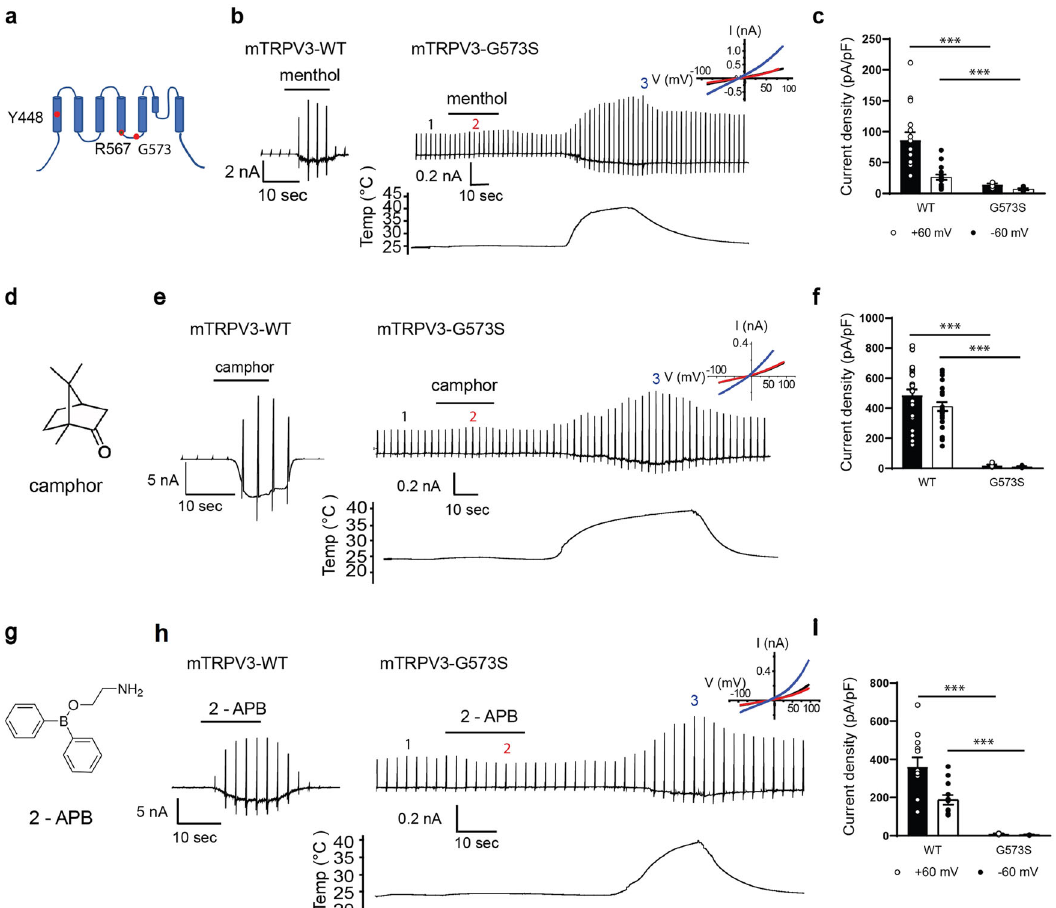
Fig. 1 Effect of TRPV3-G573S mutation on the agonistic action of menthol, camphor, and 2-APB. a Location of Y448 (S1), R567, and G573S (S4 – S5 linker) in mouse TRPV3 (mTRPV3). b Representative current traces for HEK293T cells expressing WT or mTRPV3-G573S in response to menthol (3 mM) followed by heat stimulation. c Comparison of menthol-activated current densities in HEK293T cells expressing WT or mTRPV3-G573S at ±60 mV